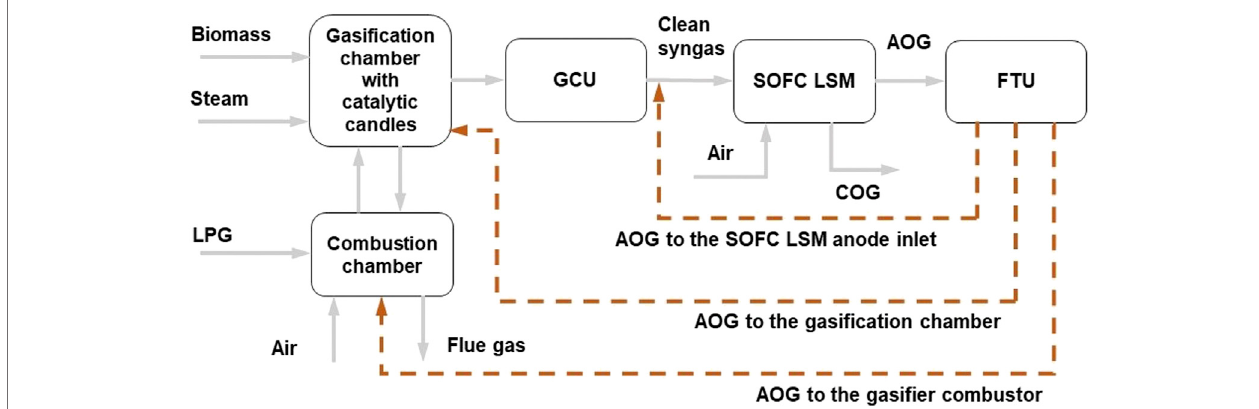
FIGURE1 | Simpli fi ed block fl owdiagram ofthe Bio-SOFC plant, pointing out the three recirculation options evaluated. GCU: gas-cleaning units, LSM: large stack module, FTU: fan turbine unit, AOG: anode off-gas, COG: cathode off-gas, and LPG: lique fi ed petroleum gas.